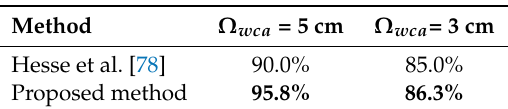
Table 3. Performance evaluation using WCA metric which describe the percentage number of frames in the test dataset where all the body-parts are detected within a certain threshold distance ( Ω wca ) from the ground truth location. Two experiments are carried out using Ω wca = 5 cm and Ω wca = 3 cm. The best results are marked in bold.